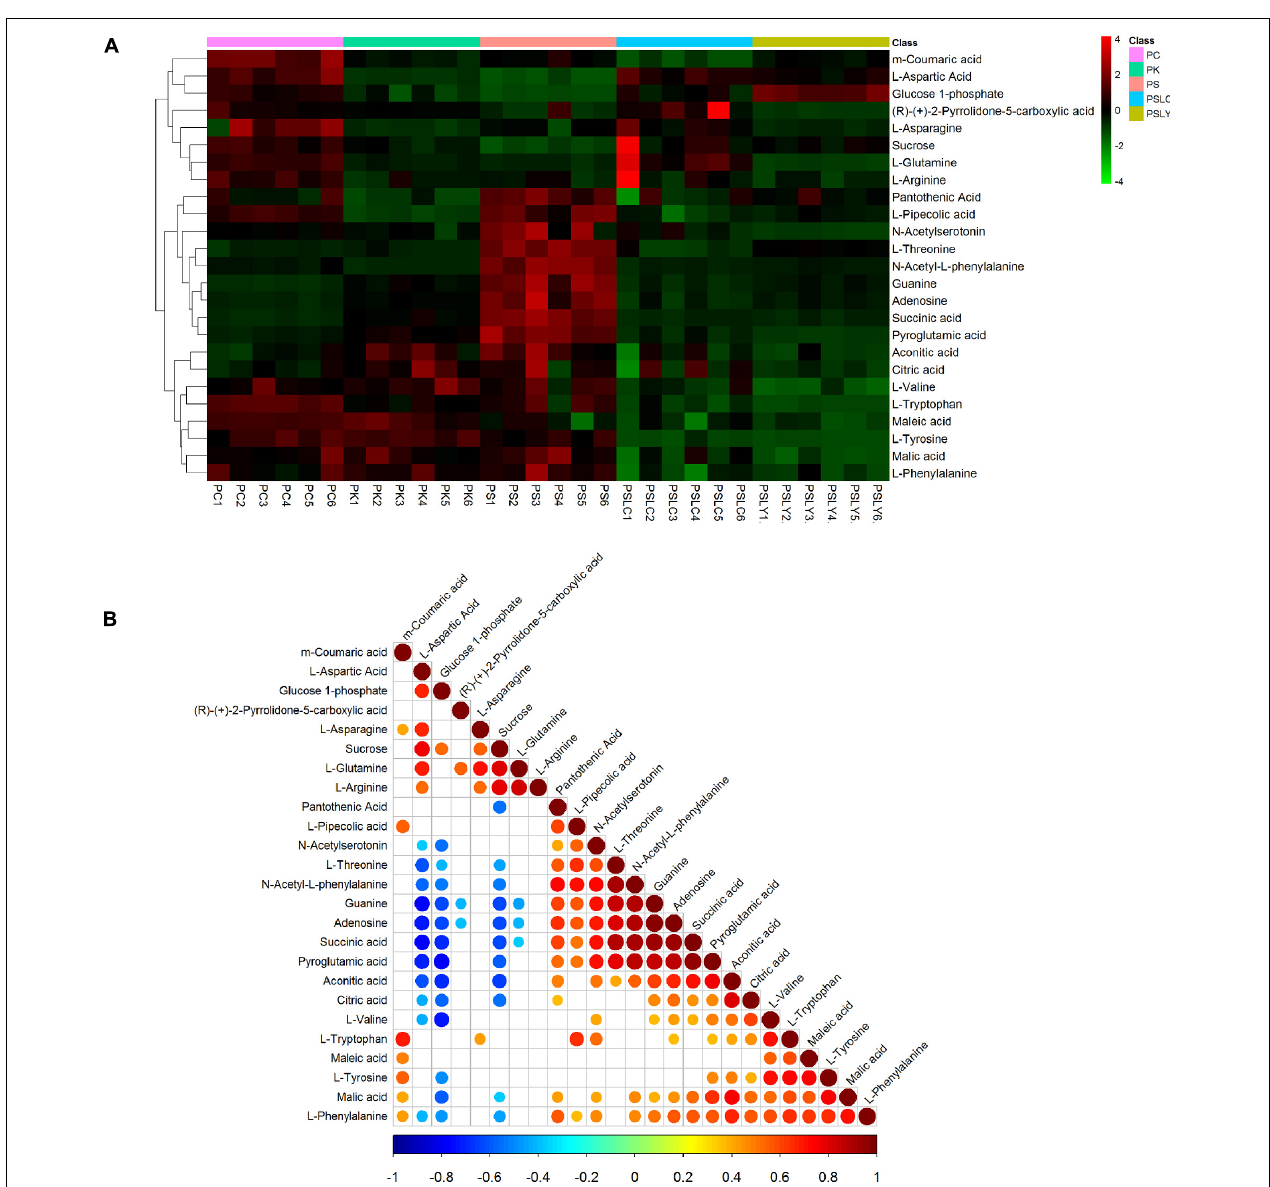
FIGURE 5 | Heat map and correlation analysis chart of differential metabolite. (A) Differential metabolite heat map. (B) Correlation analysis chart.